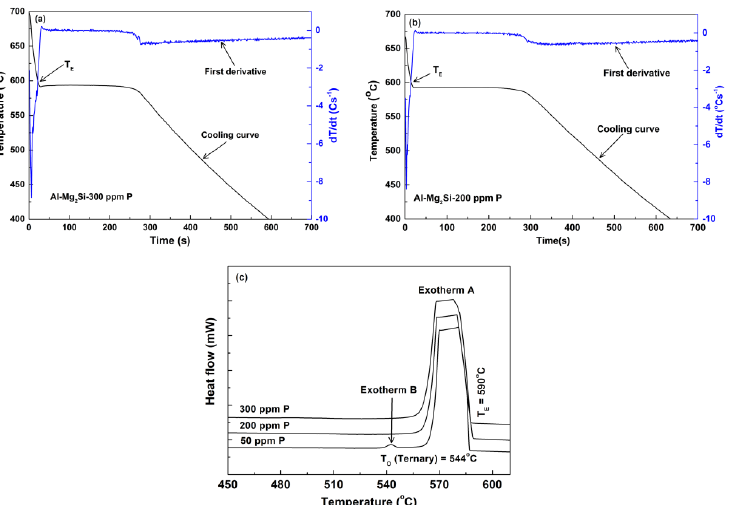
Figure 4. ( a , b ) Cooling curves for the Al-Mg 2 Si-200 ppm P and the Al-Mg 2 Si-300 ppm P eutectic alloys, respectively, and ( c ) the DSC traces of the Al-Mg 2 Si eutectic alloys with different addition levels of P cooled from 620 °C to 350 °C with a cooling rate of 20 °C/min after holding at 620 °C for 10 min.